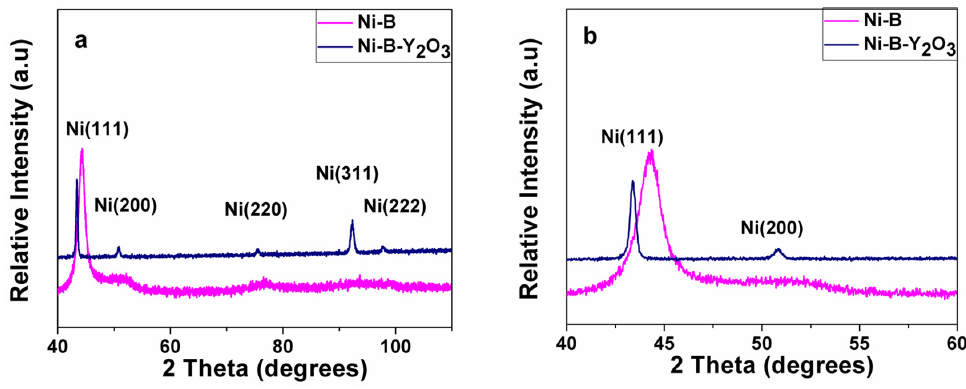
Figure 1. The large ( a ), and small scale ( b ) XRD spectra of electrodeposited Ni-B and Ni-B-Y 2 O 3 composite coatings.